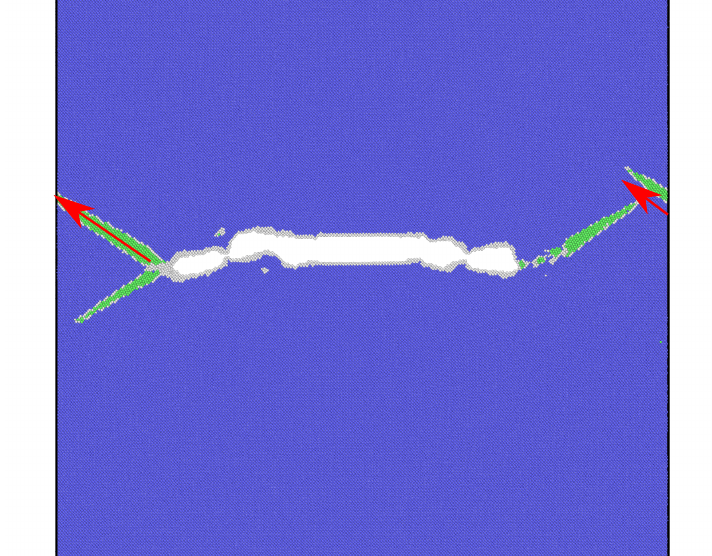
Figure 8. Self-interaction due to the periodic boundary conditions. The particles leaving the left side of the model re-enter the system through the boundary on the opposite